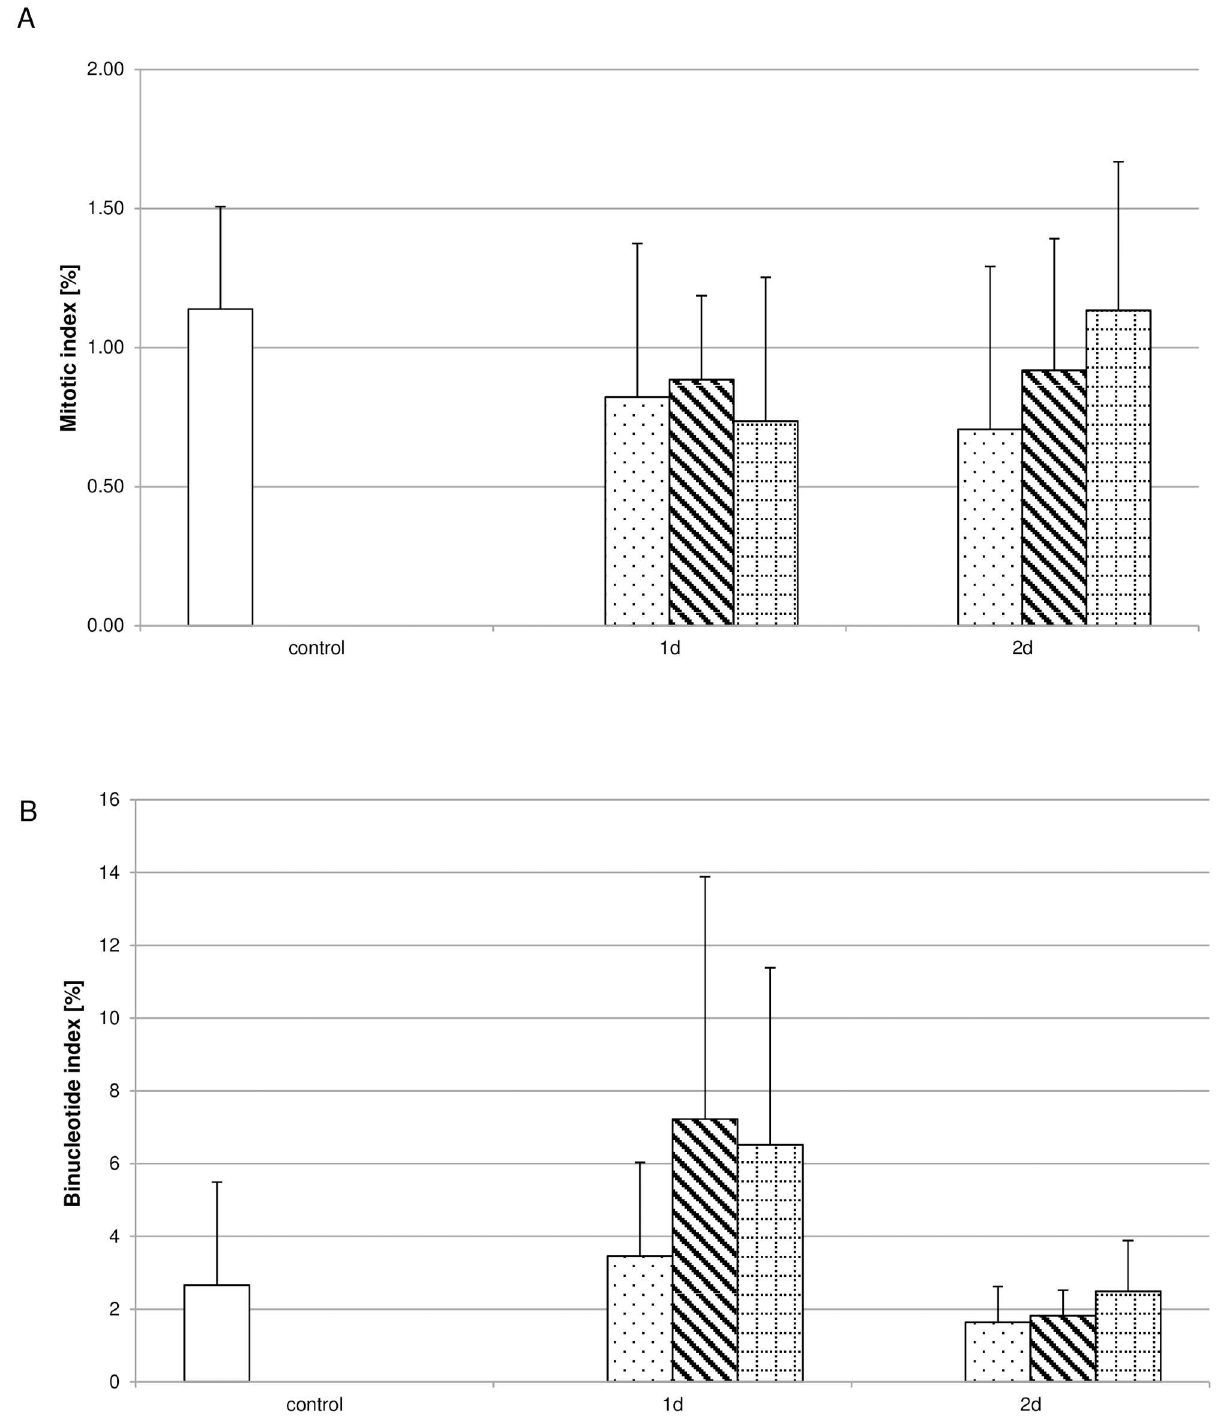
Fig 4. Biodentine ® suspensions did not influence the mitotic- or binucleotide index. The amount of cells showingcharacteristic mitotic phases (A) or binucleates (B) was correlatedto the total cell number analyzedper treatment condition. No differences could be observedbetweenthe Biodentine ® suspensionsof low (dotted bar), moderate (striped bar) or high (bricked bar) Biodentine ® or the controls (white bar). The data displayedare representative of three independentexperiments performed with comparable results. For each culture conditionapproximately 1.000 cells were